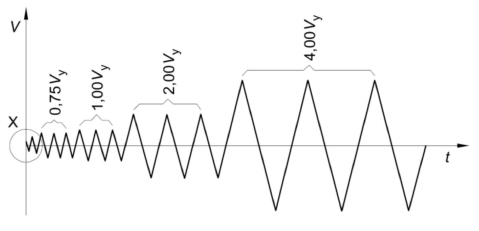
Figure 7. EN 12512 protocol [24].